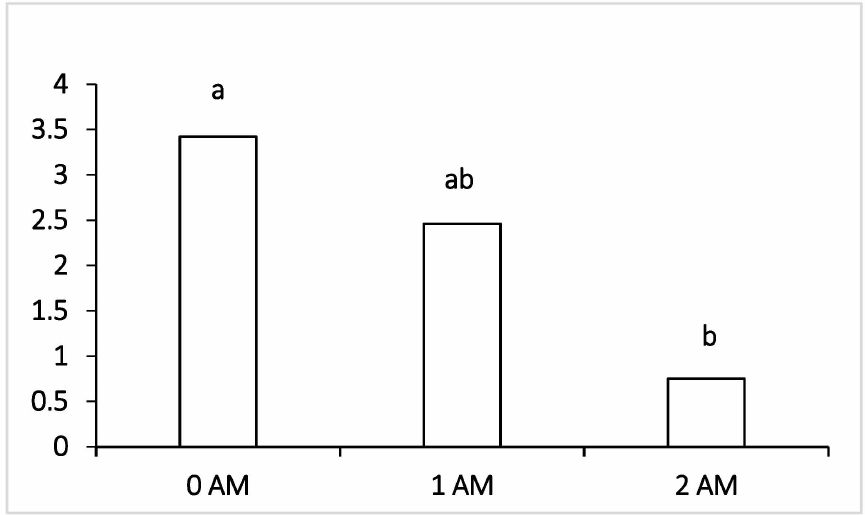
Figure 1. Effect of Agro-Matic supplementation on the rumen pathogenic microflora ( Fusobac- terium